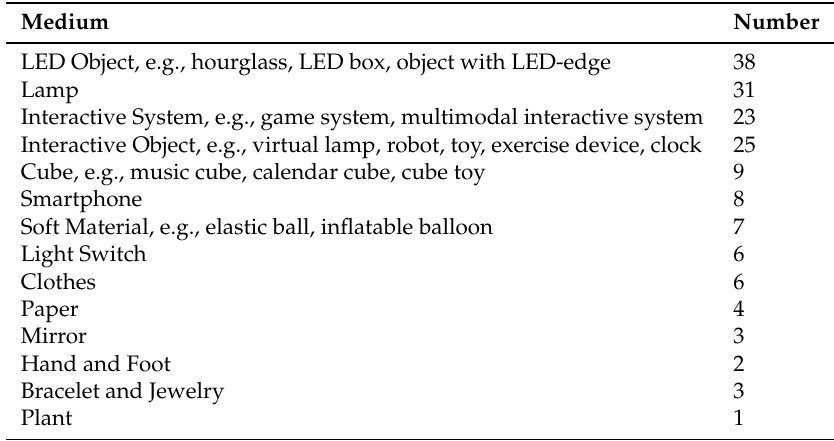
Table 7. User interface medium with tangible light in the review